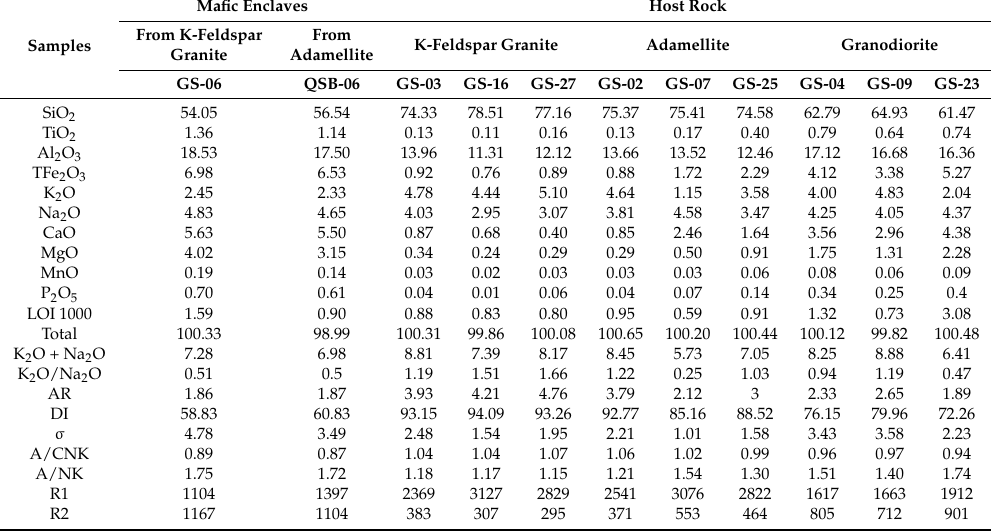
Table 3. Major element content of the Qingshanbao host rock and the mafic enclaves (wt %). Mafic Samples